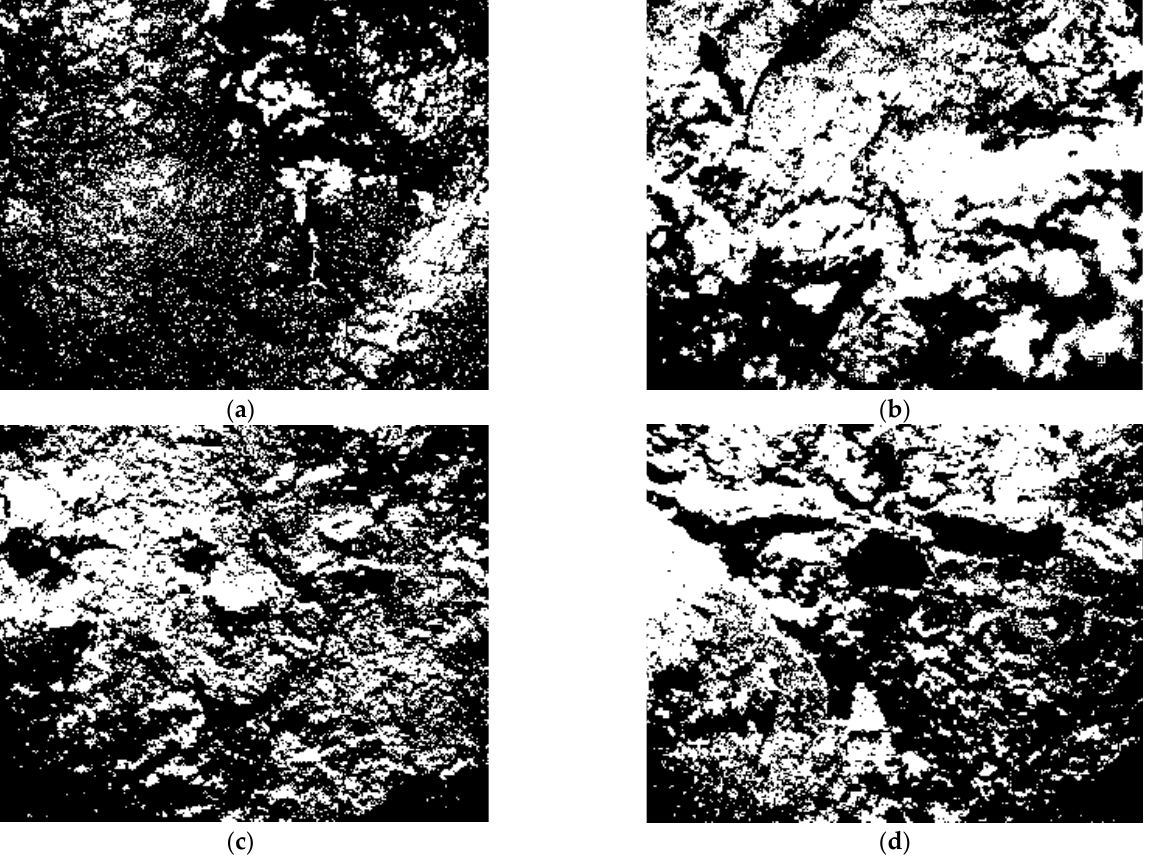
Figure 10. Binarized image of microstructure of permeation grouting muddy clay. ( a ) Cement content of 0%. ( b ) Cement content of 5%. ( c ) Cement content of 10%. ( d ) Cement content of 15%.